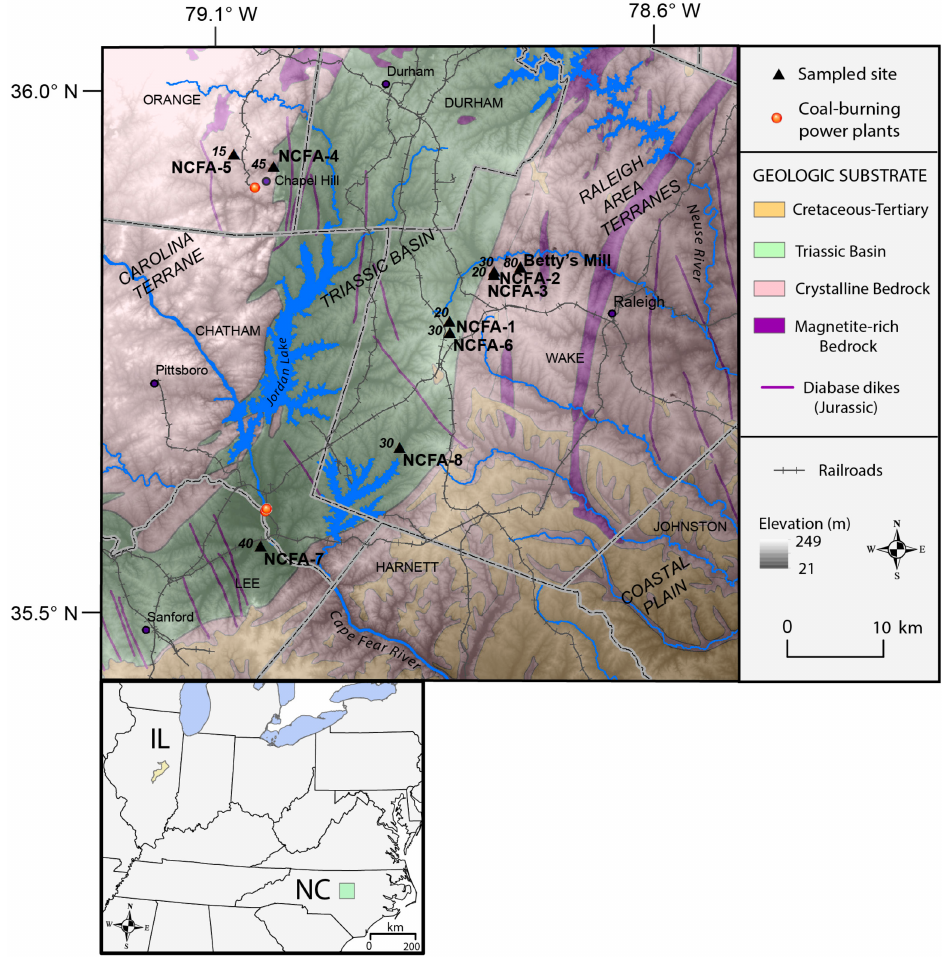
Figure 1. Location of sample sites of alluvium in the North Carolina Piedmont in the context of the generalized geology, railroads [41], and coal burning power plants (University of North Carolina [Chapel Hill] and Cape Fear [demolished in 2017]). Geologic substrate is simplified from [42]. The green square on the inset map shows the location of the North Carolina study area. The yellow area on the inset map shows the Upper Sangamon River Basin in